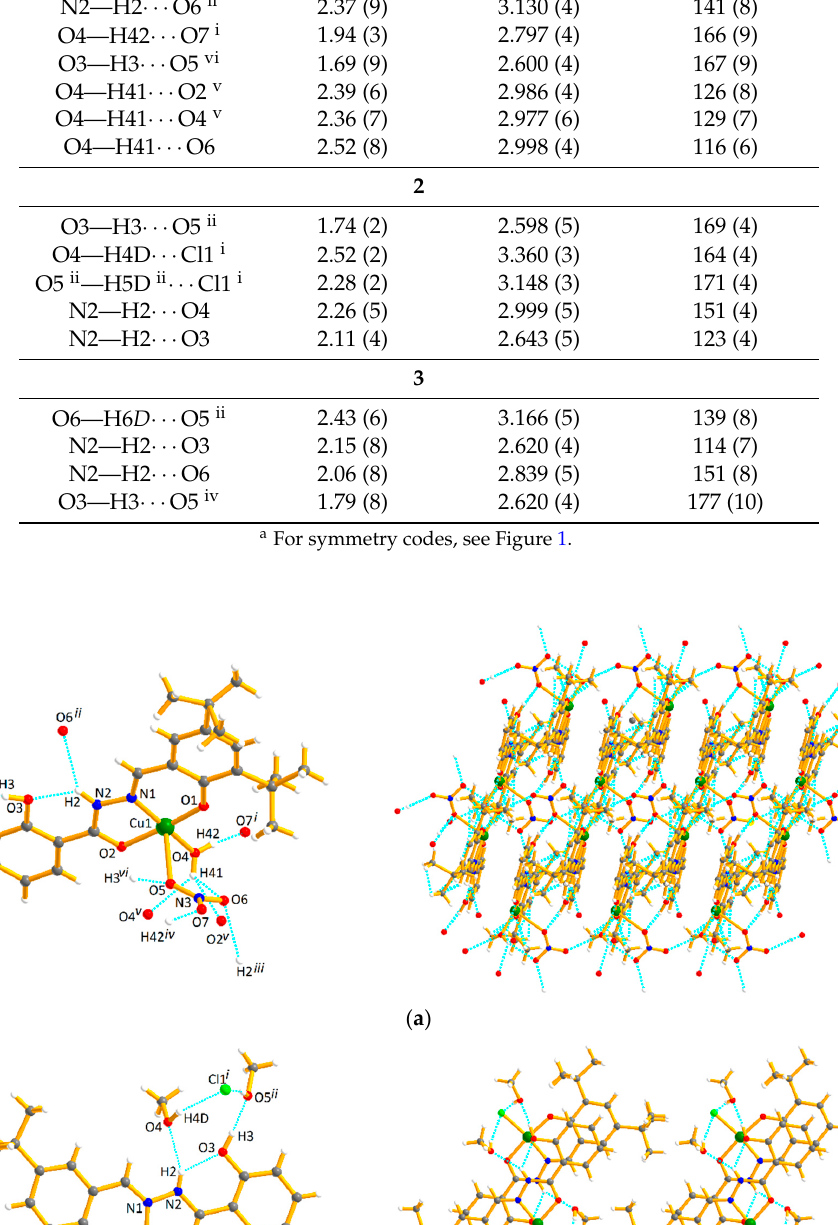
Table 3. Hydrogen-bond geometry (Å, °) in complexes 1 – 3 a .